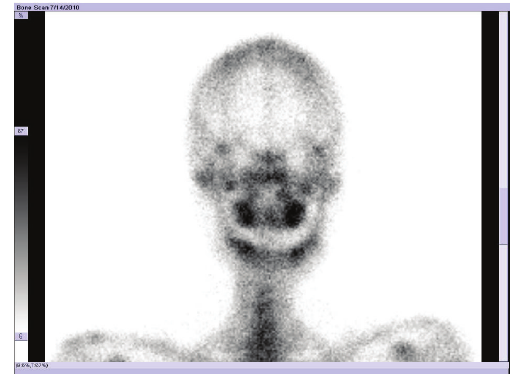
Figure 2: Anterior planar image of the head of a patient (male, 17- year old) with right side condylar hyperplasia. The center of the mandible was biased towards the left, and the bone metabolism of the right condyle was found to be active.